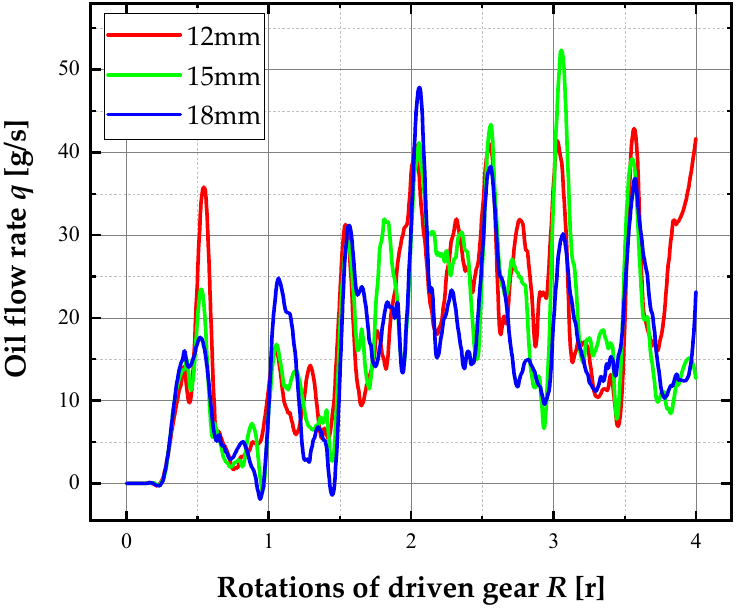
Figure 10. Oil flow rate of the meshing area at various lengths of installation end of the oil-guiding tube. The variation of the lubricating oil flow rate in the gear-meshing area under the conditions of different angles of the oil-guiding tube is represented in Figure 11. For oil- guiding tubes with different angles, the corresponding lubricating oil flow curves have a high degree of overlap. The average flow rate of θ = 70 ◦ , 90 ◦ , and 110 ◦ are 17.6 g/s, 18.4 g/s, and 18.7 g/s, correspondingly. This indicates that when the oil-guiding tube is fully immersed in the lubricating oil, the change in the angle of the oil-guiding tube has little impact on the lubricating oil flow rate in the gear-meshing